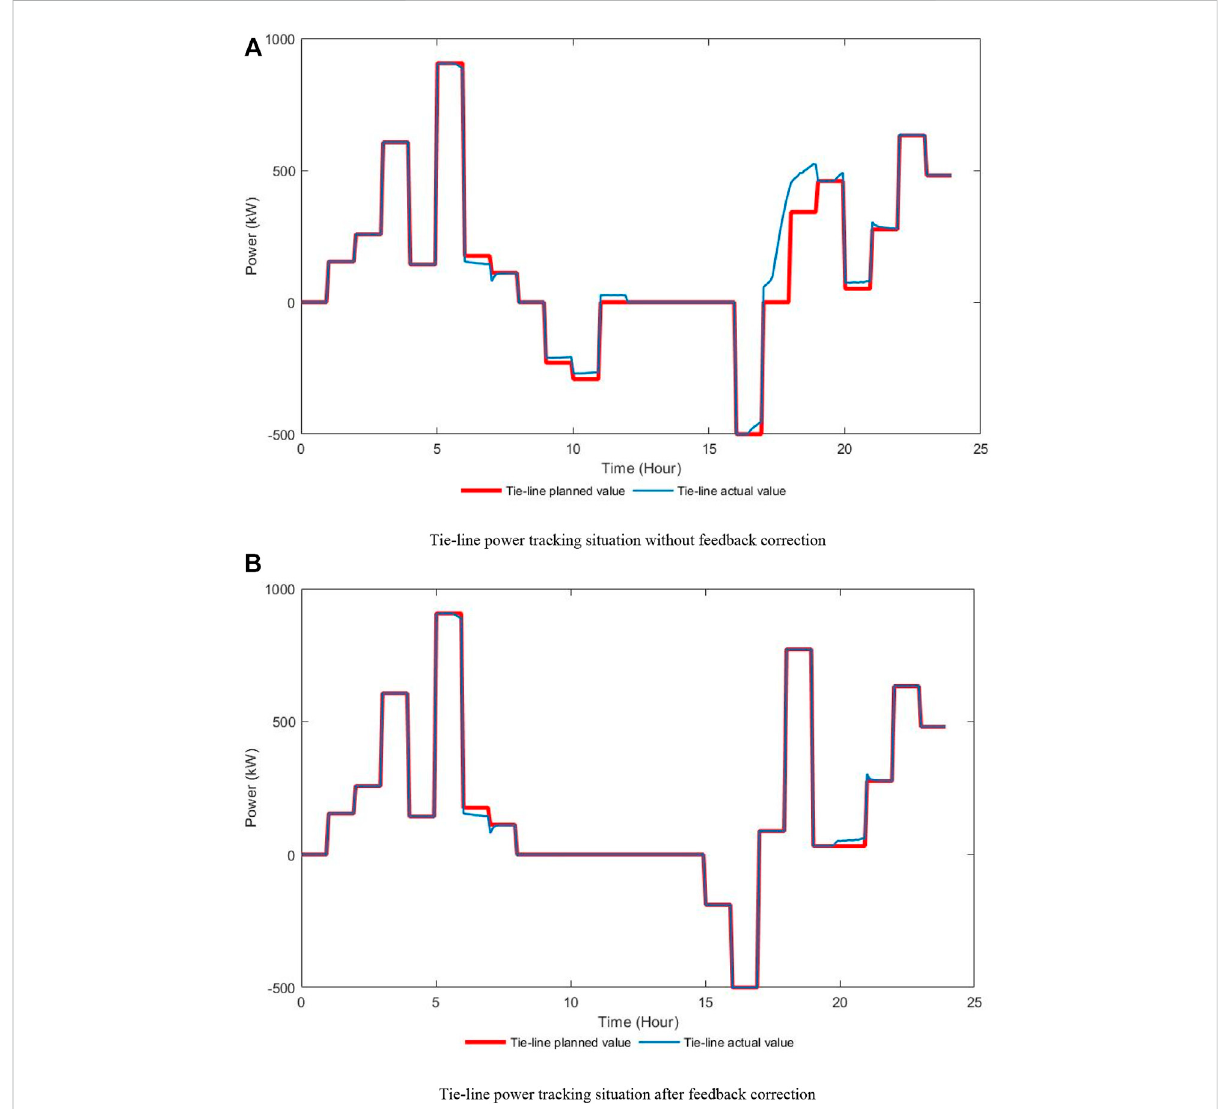
FIGURE 10 Tie-line power tracking situation. (A) Tie-line power tracking situation without feedback correction. (B) Tie-line power tracking situation after feedback